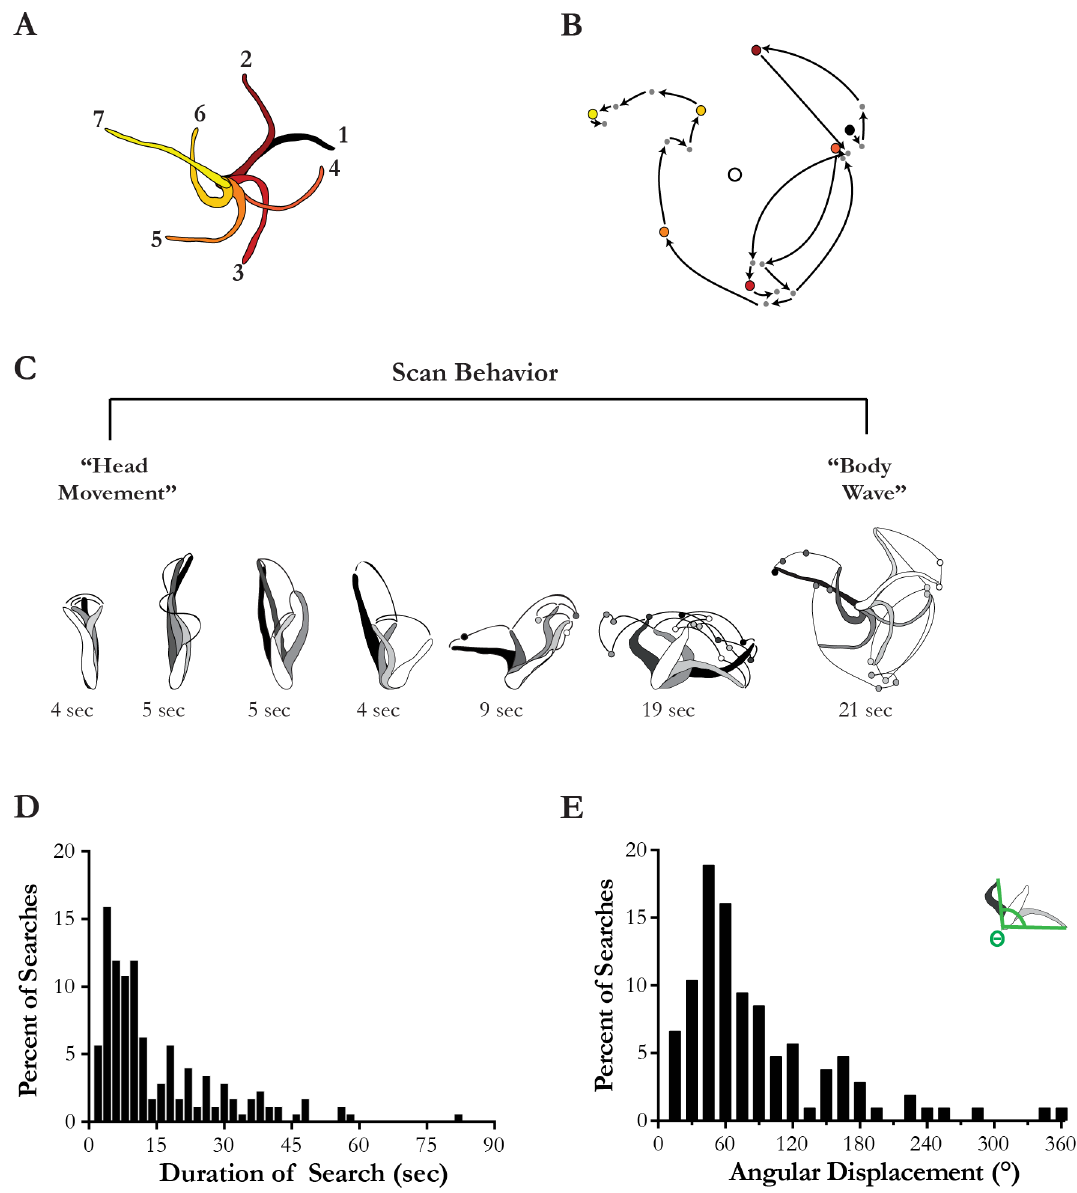
Figure 1. Qualitative description of scan behavior. A) Tracings of body position during every 3 seconds of a scanning behavior sequence. B) The head position during a scan sequence is marked with a circle for each second. The large colored circles correspond to positions marked in the drawing in A, the small dots represent each second in between. The open circle in the middle represents the position of the caudal sucker. Arrows denote the approximate path of the leech’s head during this sequence. C) ‘‘Head movement’’ and ‘‘body waving’’ were previously described as different behaviors, but represented here on a continuum. Different sequences of scanning behavior from the same video of the same animal are shown. Each second is denoted with either a tracing of the leech’s body or, when that tracing would obscure the movements of the animal, a dot. The order of these positions is denoted by the color, which starts with white and gets progressively darker until the last position shown in black. To further assess whether or not these behaviors exist on a continuum, we measured two parameters duration and angular displacement. D) The distribution of scan durations is represented here for 99 scans from 18 individuals presented with a stimulus (black). E) The distribution of angular displacements (see inset) for 99 scans from 18 individuals presented with an 8 Hz